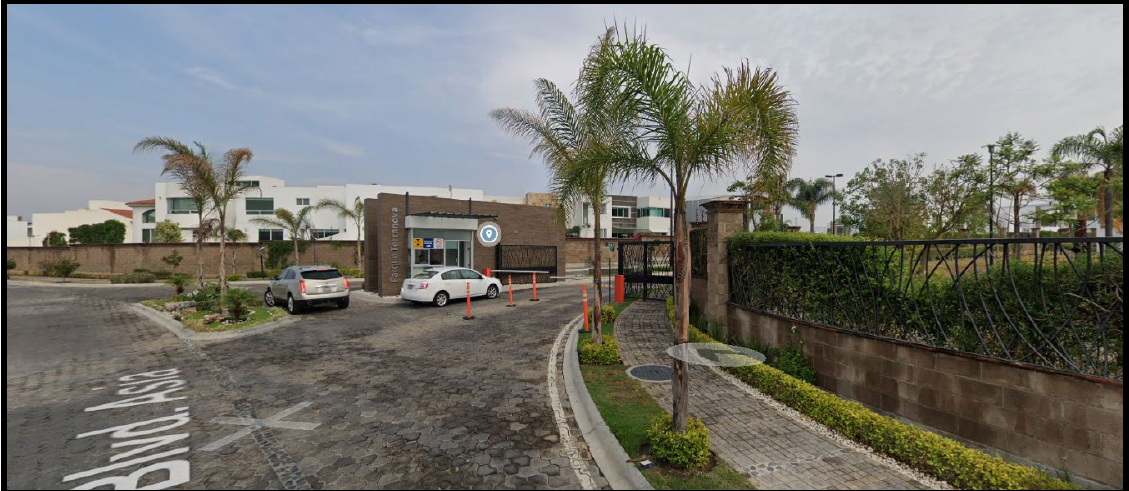
Figure 5. Image from an entrance to a “ Lomas de Angelópolis ” cluster as a manifestation of the fractures in urban fabric due to neoliberal model of urbanization. Retrieved from google maps (2022).